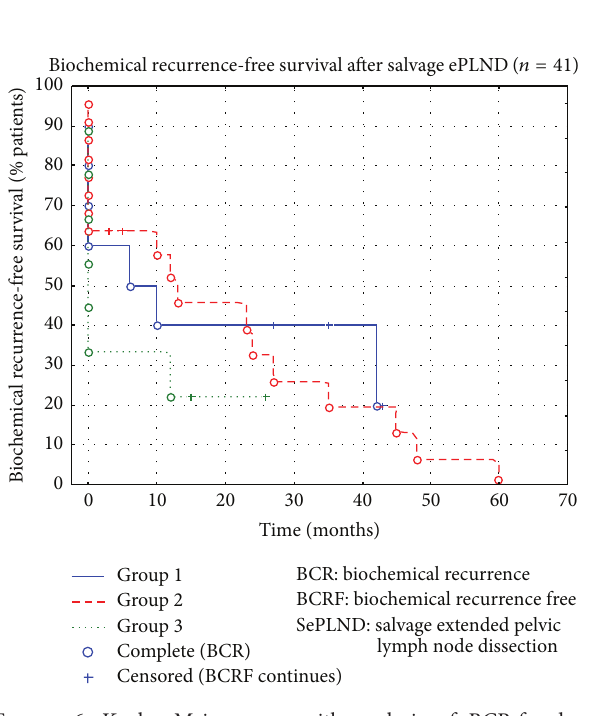
Figure 6: Kaplan-Meier curve with analysis of BCR-freedom survival in 3 groups ( 𝑛 = 41 ).